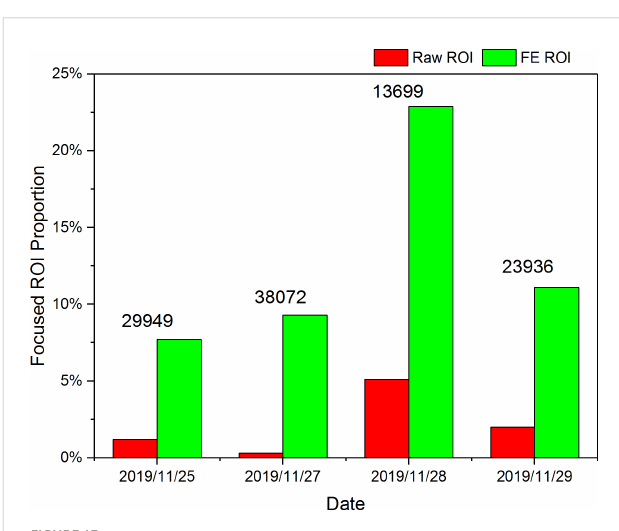
FIGURE 13 Proportion change of the clear ROI images in a 4-day in situ image data acquired by an IPP camera deployed underwater before and after all the raw ROIs processed by IsPlanktonFE.